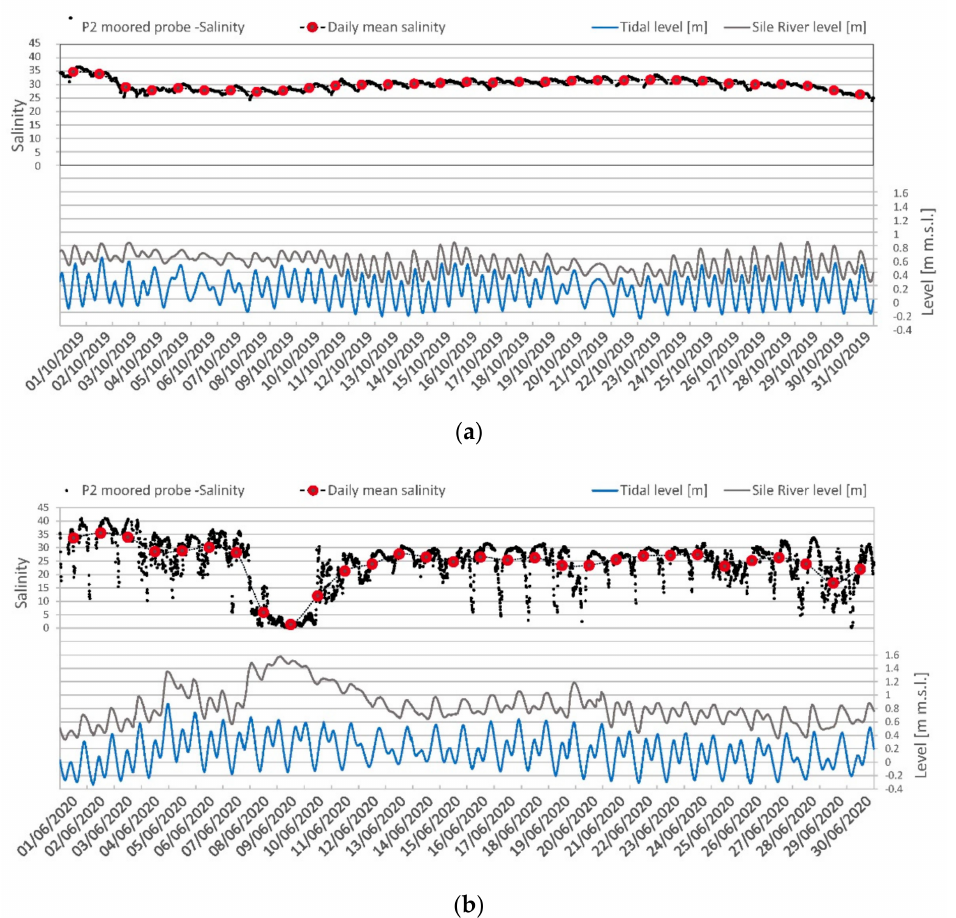
Figure 6. Data of salinity (10 min of frequency) registered in 10/2019 (( a ), ante operam condition) and June 2020 (( b ), post operam condition) in P2 moored probe. Comparison with lagoon tidal level and Sile River level data is reported to show the complex trend of salinity as a function of the tidal level and its interaction with fresh water flows. Table 5. Statistics of monthly mean values of salinity before the establishment of a regular fresh water flow (May 2020) acquired by P2 moored probe installed in the middle of the area of interest. Period Mean